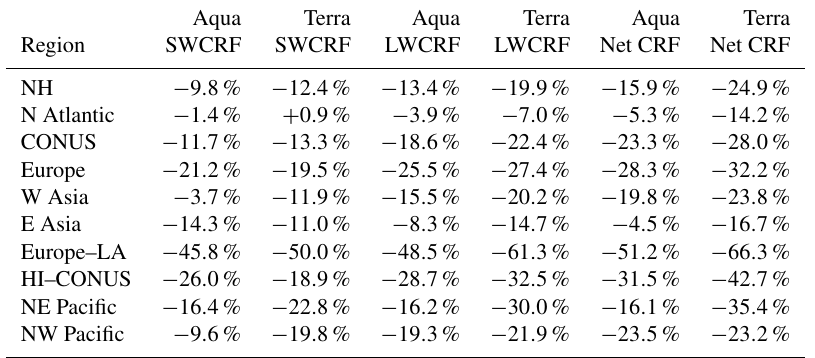
Table 5. Relative change in total contrail radiative forcing between 2006 and 2012 for the Northern Hemisphere and nine air traffic regions. Aqua Terra Aqua